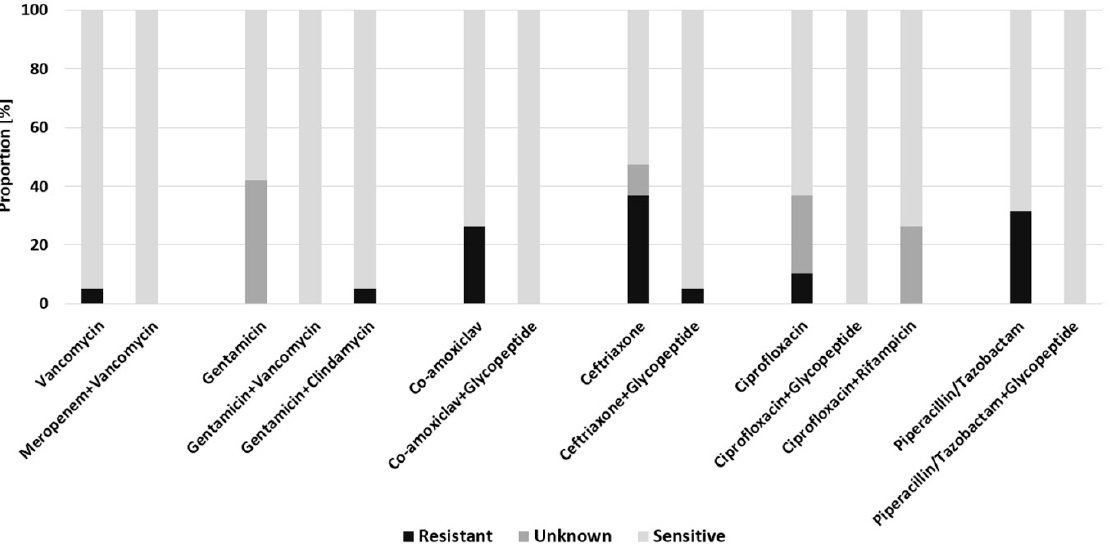
Figure 2. Predicted efficacy of empiric antimicrobial regimens for patients with early-onset of in- fection.